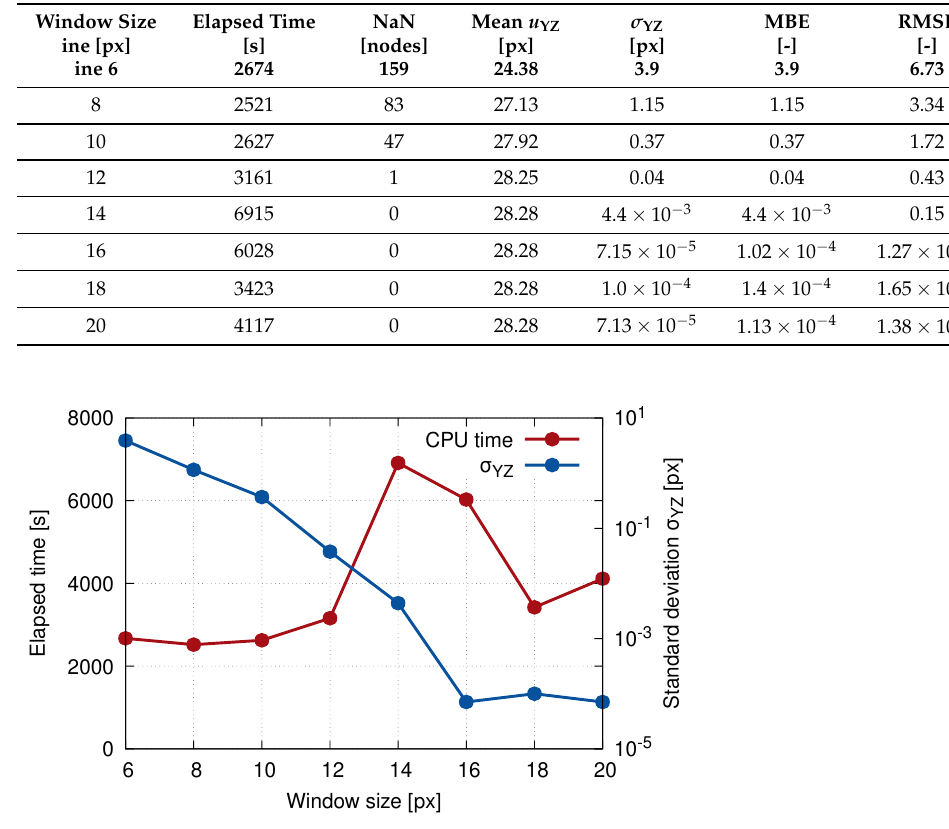
Figure 8. The elapsed time of the calculation and standard deviation plotted against the correlation window size showing the result of the DVC precision